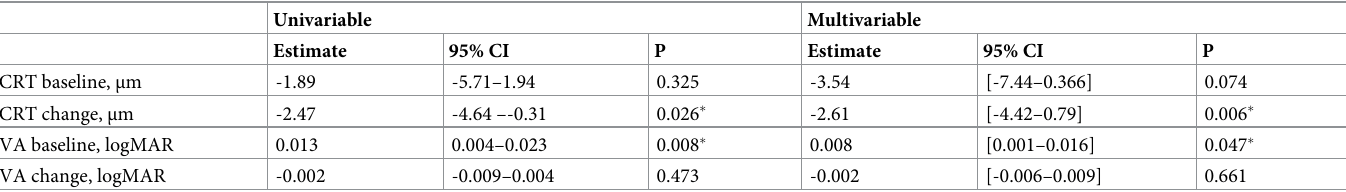
Multivariable analyses were corrected for gender, age, duration of DME, DR stage, presence of cysts, presence of subretinal fluid, disruption of the external limiting membrane, disruption of the photoreceptor layer and the presence of disorganization of the retinal inner layers. Analyses of CRT and VA changes were also corrected for both CRT baseline and VA baseline. Analysis of CRT baseline was also corrected for VA baseline, and analysis of VA baseline was also corrected for CRT baseline. CI = confidence interval; HF = hyperreflective foci; CRT = central retinal thickness � P <